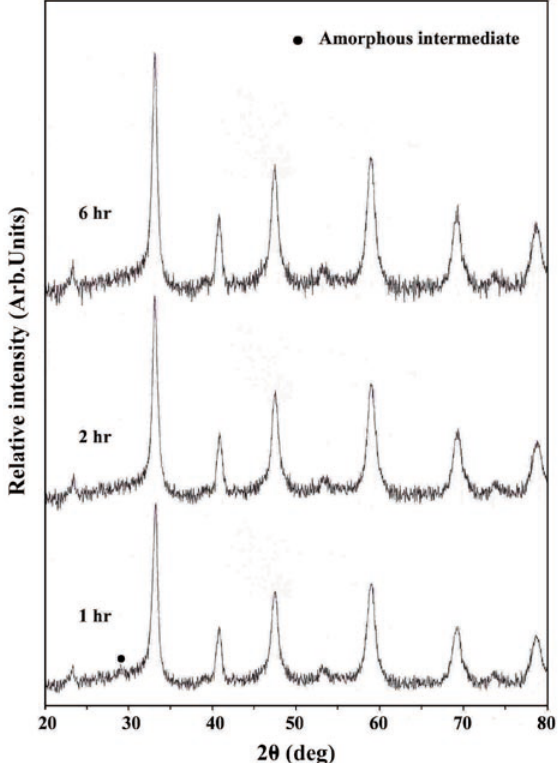
Figure 6. XRD of La